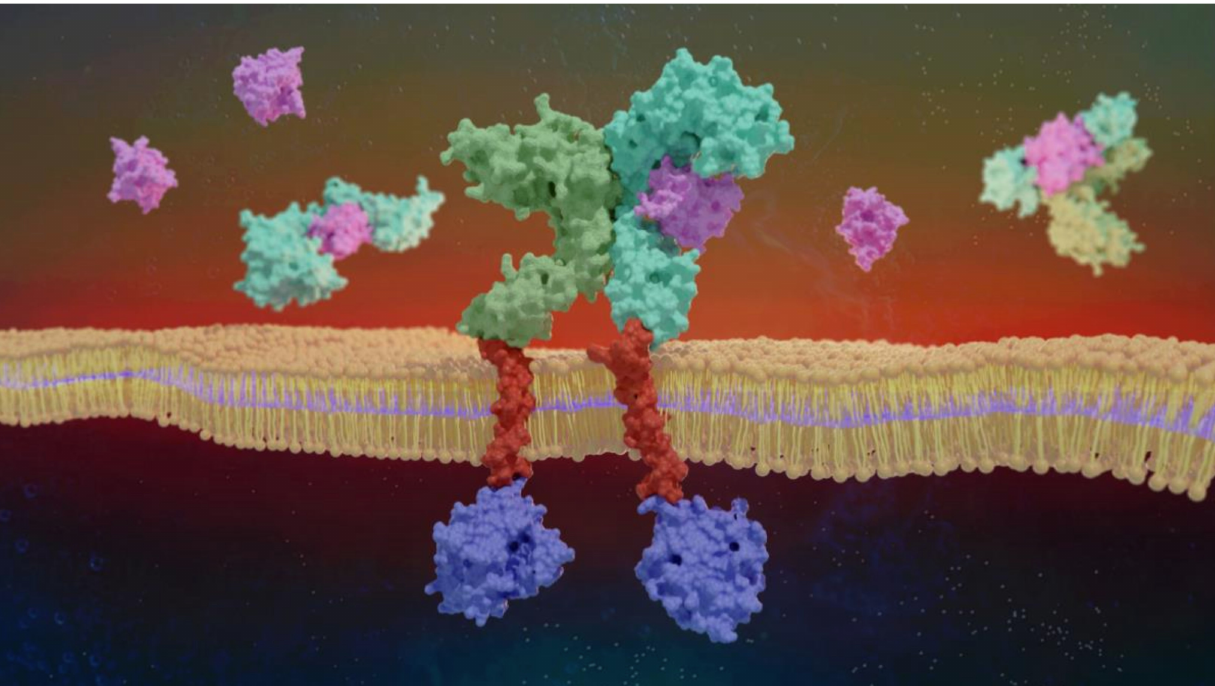
Figure 1. An illustration of the IL-1 β /IL-1R1/IL-1RAcP ternary complex. Binding of the IL-1 cytokine (colored in pink) to the membrane-bound IL-1R1-ECD (colored in green) recruits transmembrane IL-1RAcP (colored in lime), initiating intracellular signaling via the TIR domains (colored in blue). Both IL-1R1 and IL-1RAcP can participate in the negative regulation of IL-1 signaling when cleaved to their soluble ECD forms. The lipid bilayer (cell membrane) is represented in yellow and trans- membrane domains are colored in red. The image was generated using imported VMD visualization states [33] uploaded in the Blender software [34]. Figure abbreviations: IL-1, interleukin-1; IL-1R1, interleukin-1 receptor type 1; IL-1R1-ECD, extracellular domain of IL-1R1; IL-1RAcp, interleukin-1 receptor accessory protein; TIR domain, the toll-interleukin-1 receptor homology